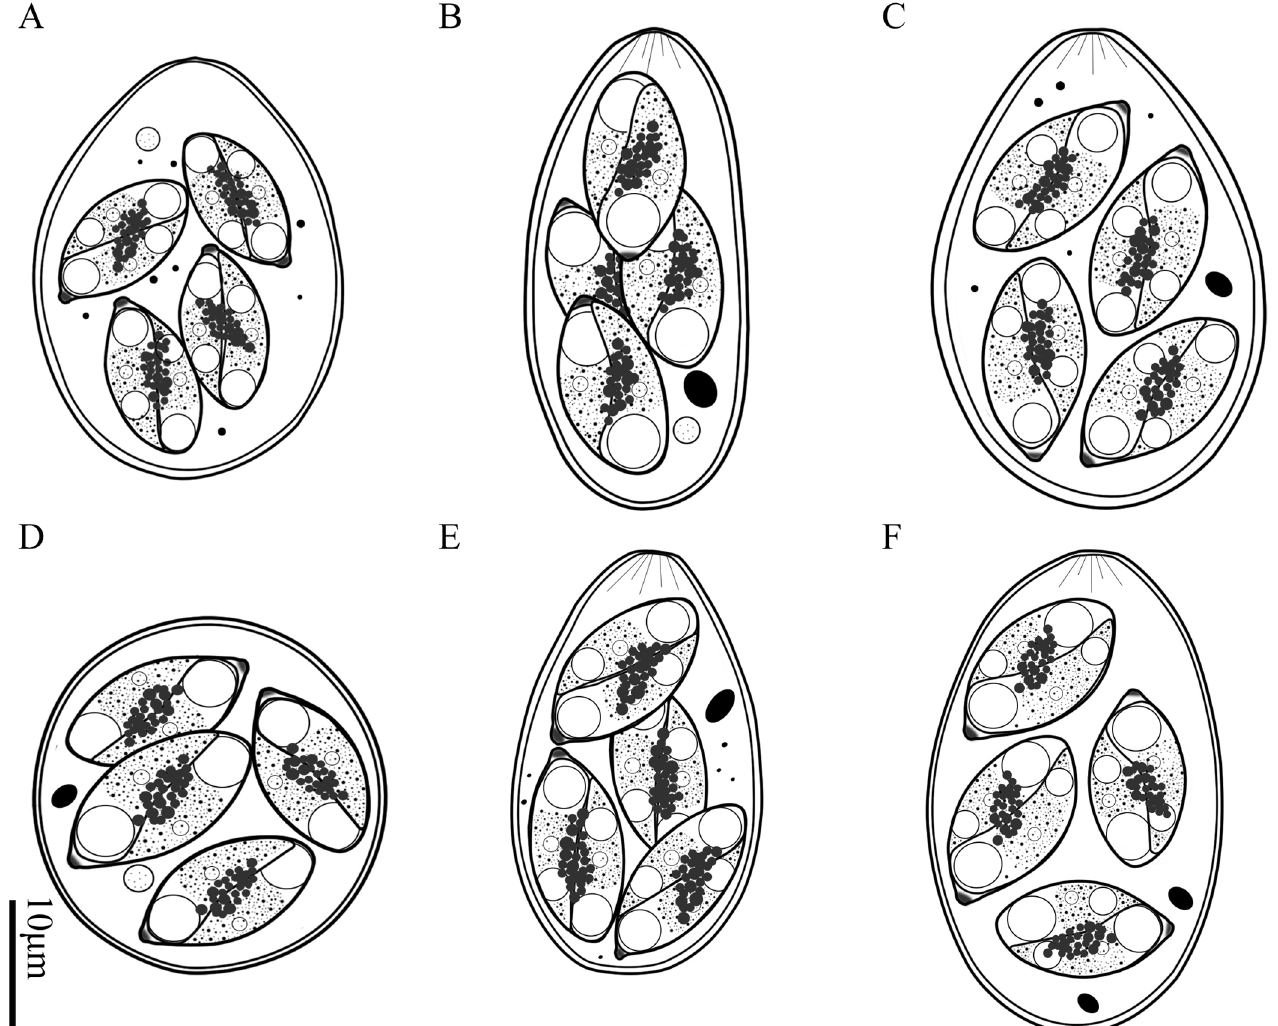
Figure 2. Line drawings of the sporulated oocysts of the six Eimeria species discovered and described from forest musk deer. A. Eimeria aquae n. sp.; B. Eimeria dolichocystis n. sp.; C. Eimeria fengxianensis n. sp.; D. Eimeria helini n. sp.; E. Eimeria kaii n. sp.; F. Eimeria oocylindrica n.